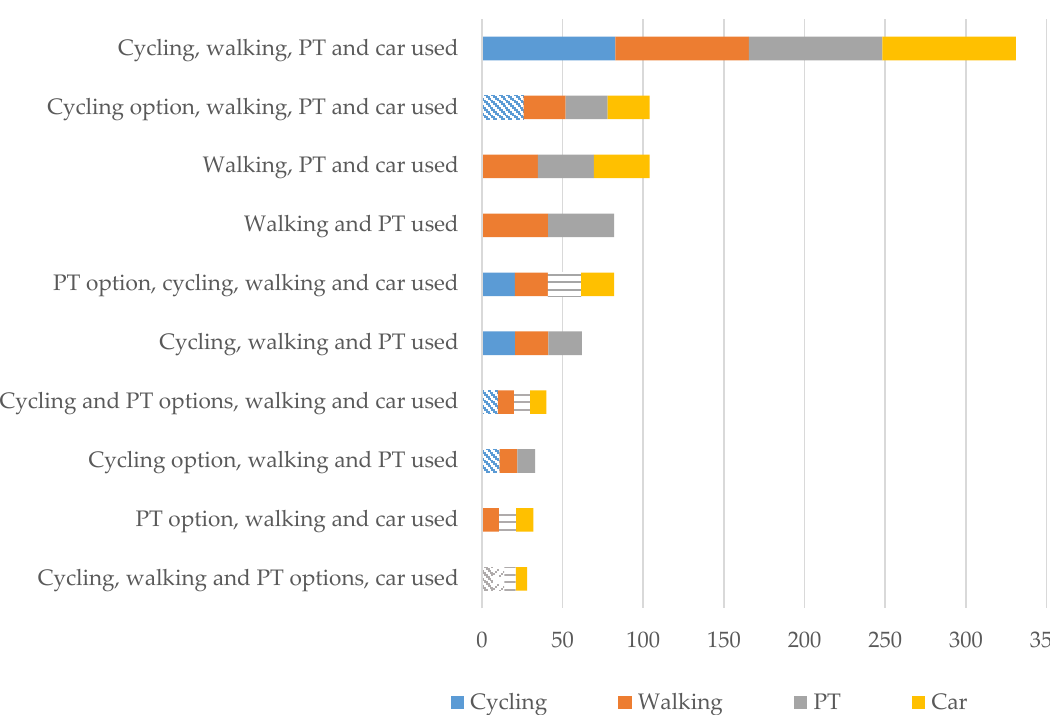
Figure 1. Illustration of the most common modal choice processes. Those filled with a pattern indicate a modal option that has not been used. The modes encompassed in each selection process are given equal representation in the chart. This, however, is purely for illustration purposes and is not intended to reflect the extent to which individuals use the respective modes; PT — indicates public transport.